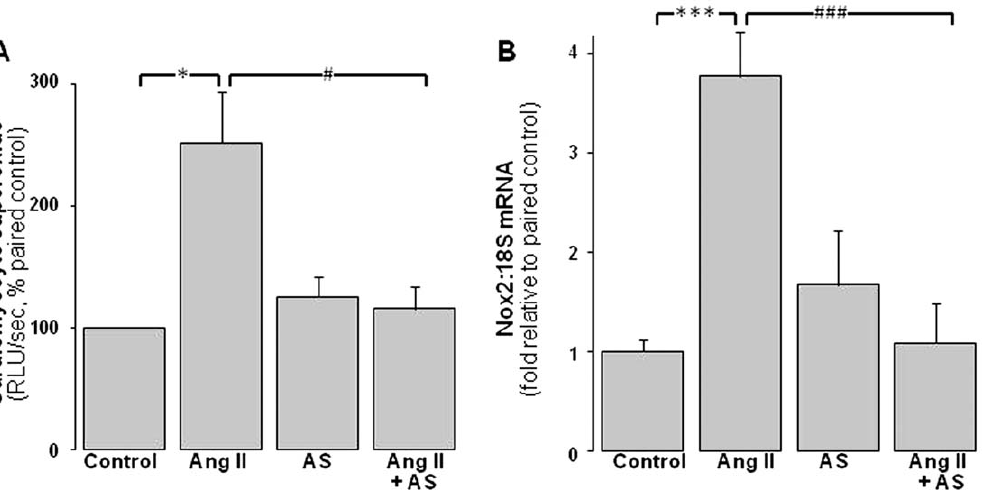
Figure 2. ROS-suppressing actions of Angeli’s salt. AS (1 m mol/L, added 4 6 /day over 48 h) blocks cardiomyocyte NADPH oxidase activity and expression. A Ang II (1 m mol/L, final 24 h)-induced superoxide generation (lucigenin chemiluminescence, n=11 myocyte preparations); B Ang II (1 m mol/L, 48 h)-induced cardiomyocyte Nox2 gene expression (n=8 myocyte preparations). *P , 0.05 and ***P , 0.001 vs control; # P , 0.05 and ### P , 0.001 vs Ang II